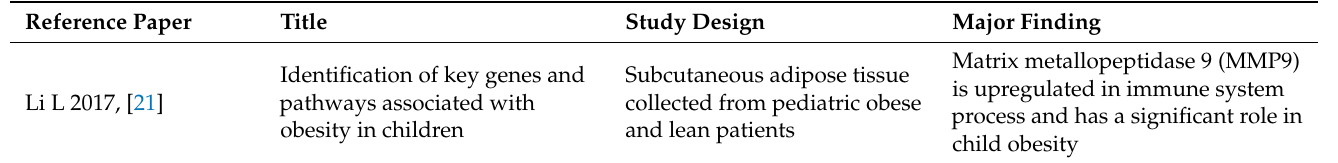
Table 1. Summary of Childhood Obesity published